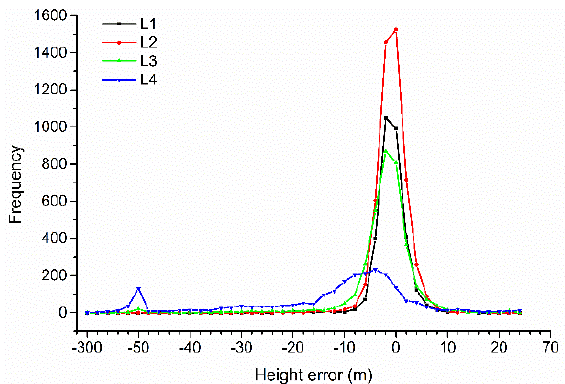
Figure 8. Building height error distribution comparison among four block FAR levels.